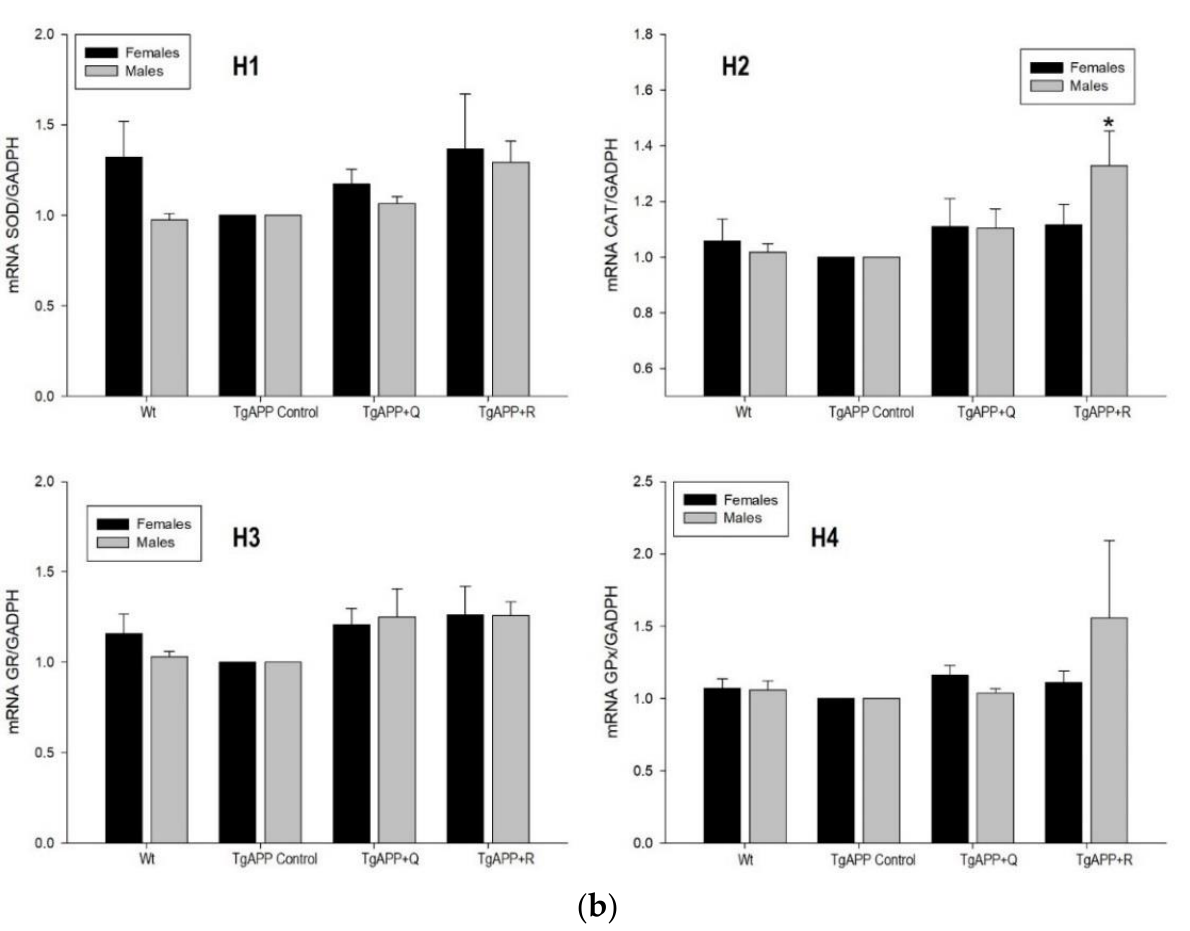
Figure 5. ( a ). Effect of quercetin (Q) and rutin (R) on SOD (C1), CAT (C2), GR (C3), and GPx (C4) expression in Cortex (C). (1) WT; (2) TgAPP control; (3) TgAPP + Q; (4) TgAPP + R. ( b ). Effect of quercetin (Q) and rutin (R) on SOD (H1), CAT (H2), GR (H3), and GPx (H4) expression in the Hippocampus (H). (1) WT; (2) TgAPP control; (3) TgAPP + Q; (4) TgAPP + R. * p < 0.05 vs. TgAPP control (ANOVA followed by the post-hoc Newman–Keuls multiple comparison test).